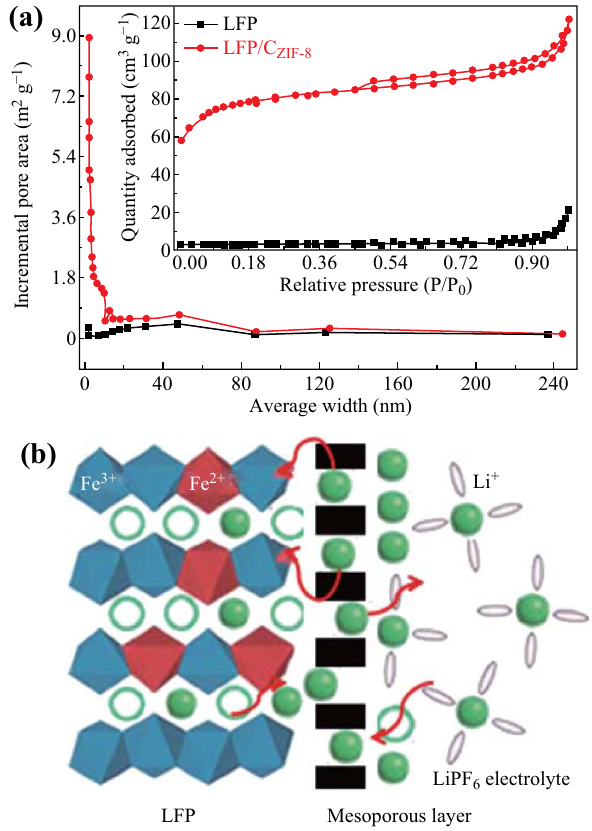
Fig. 4 a Barrett–Joyner–Halenda pore-size distribution and the isotherm shape of LFP and LFP/C ZIF-8 . b Working mechanism of the coating layer in LFP/C ZIF-8